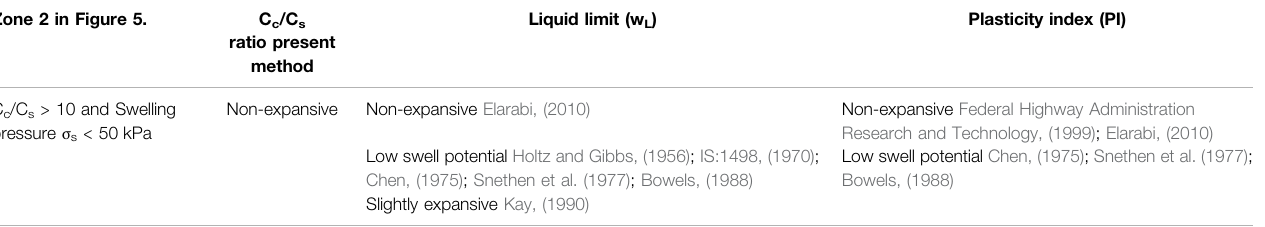
TABLE 3 | Comparison of C c /C s ratio method to others methods. Zone 2 in Figure 5.